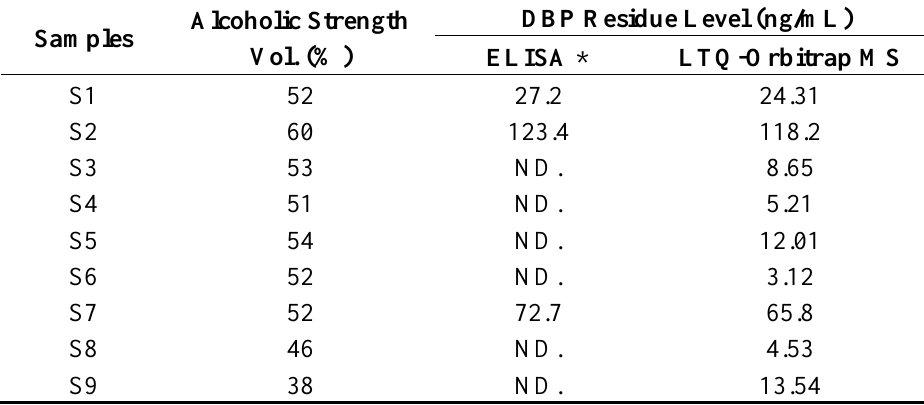
Table 3. Detection of DBP residues in marketed liquor